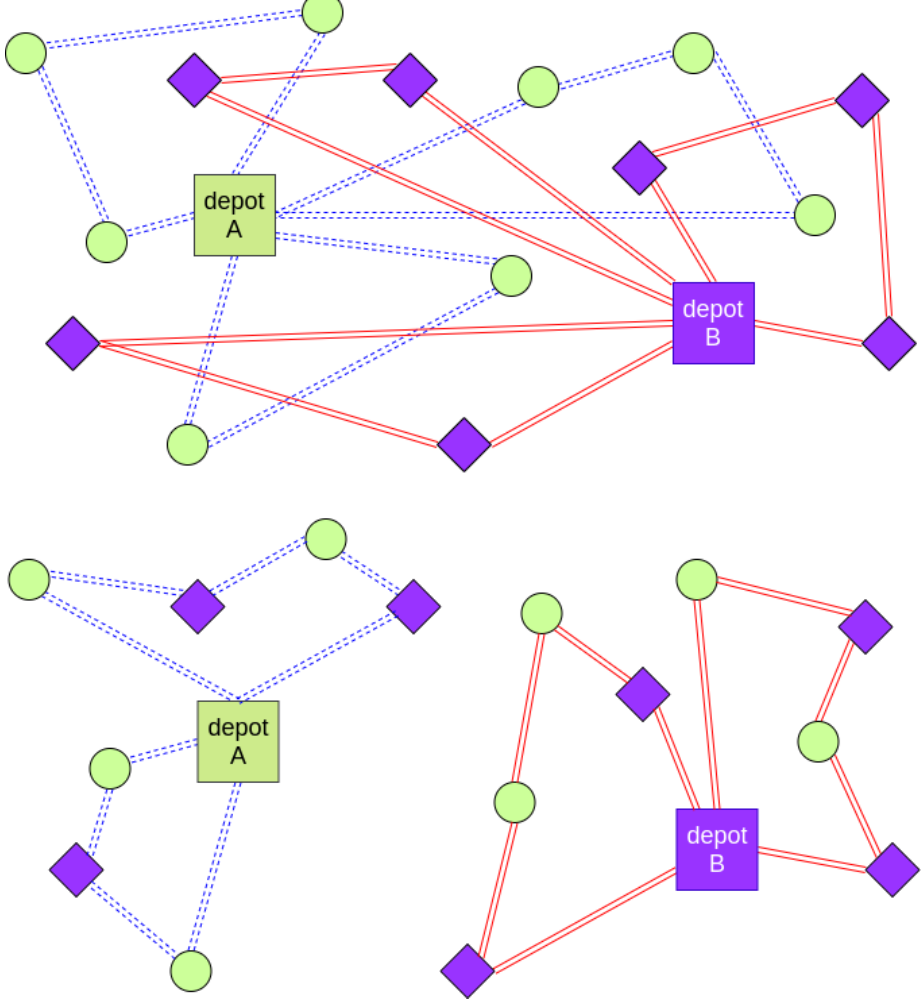
Figure 7. Using horizontal cooperation strategies to reduce energy consumption and gas emissions during transportation